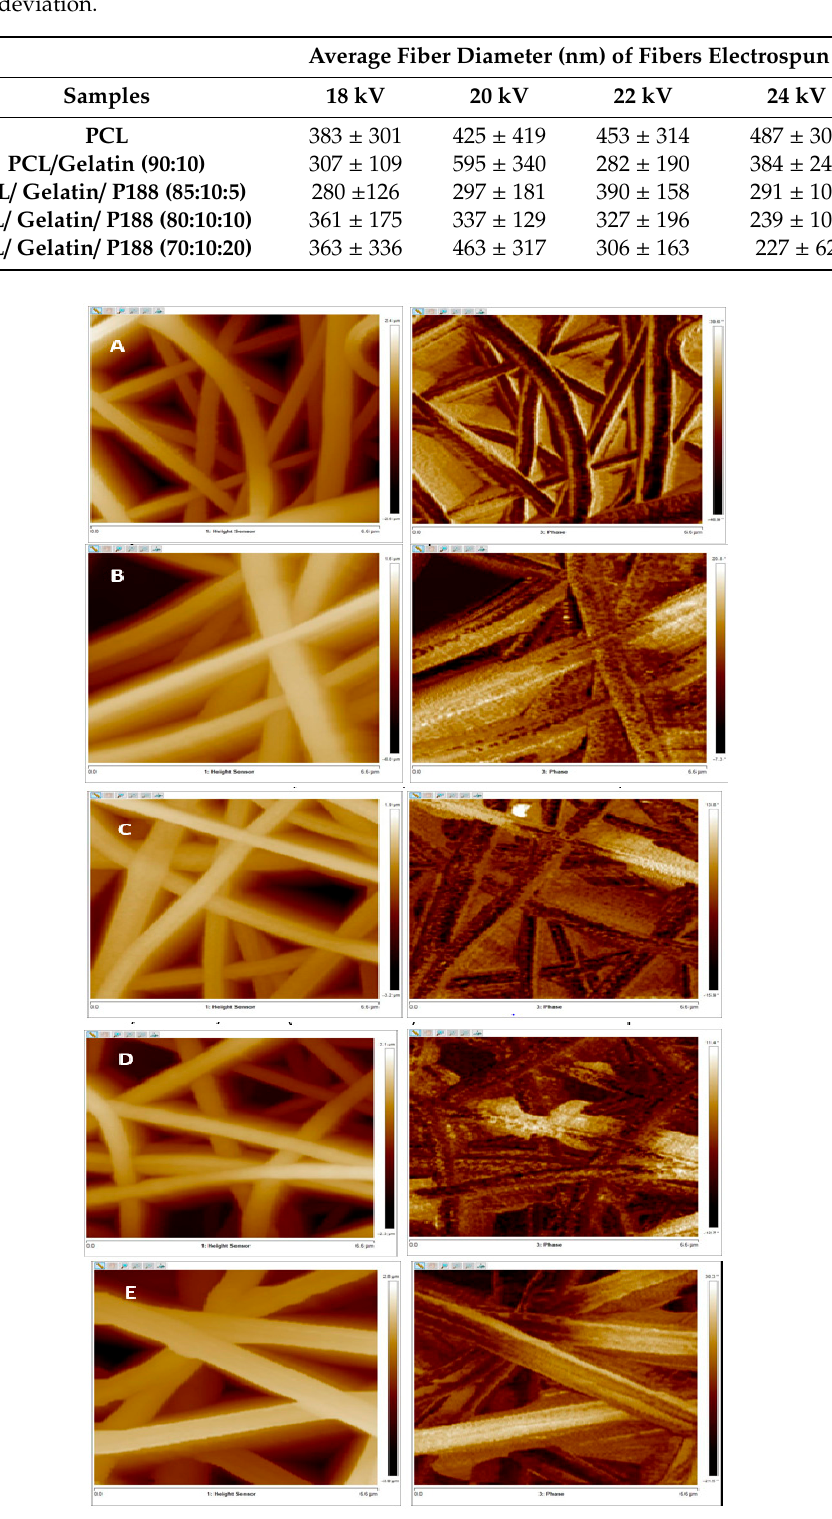
Table 2. The average fiber diameter (n = 100) of the five di ff erent fibrous sca ff olds along with their standard deviation.